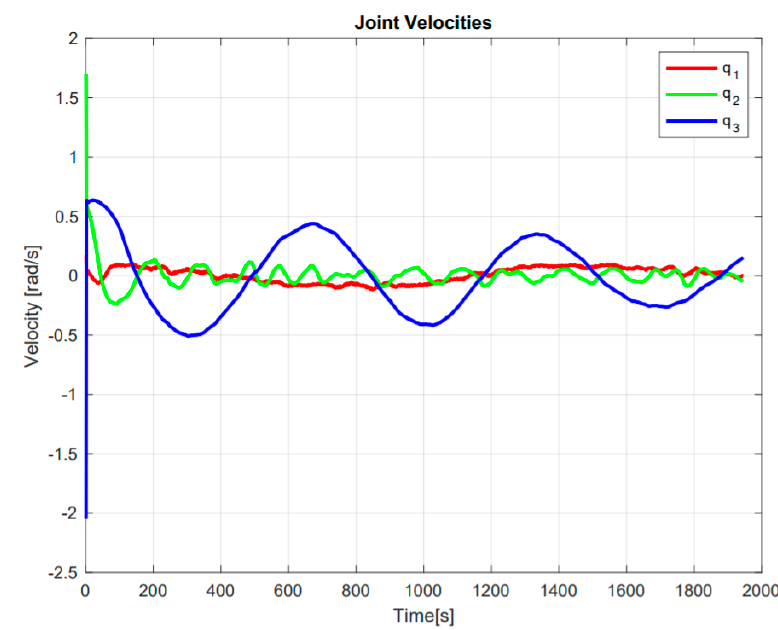
Figure 17. Joint velocities: LAMDA controller.